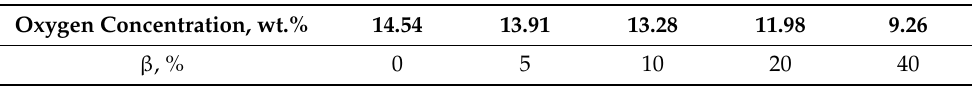
Table 10. Calculated values of oxygen concentration in reduced mixed REM oxide pellets considering that the reduction degree ( β ) is